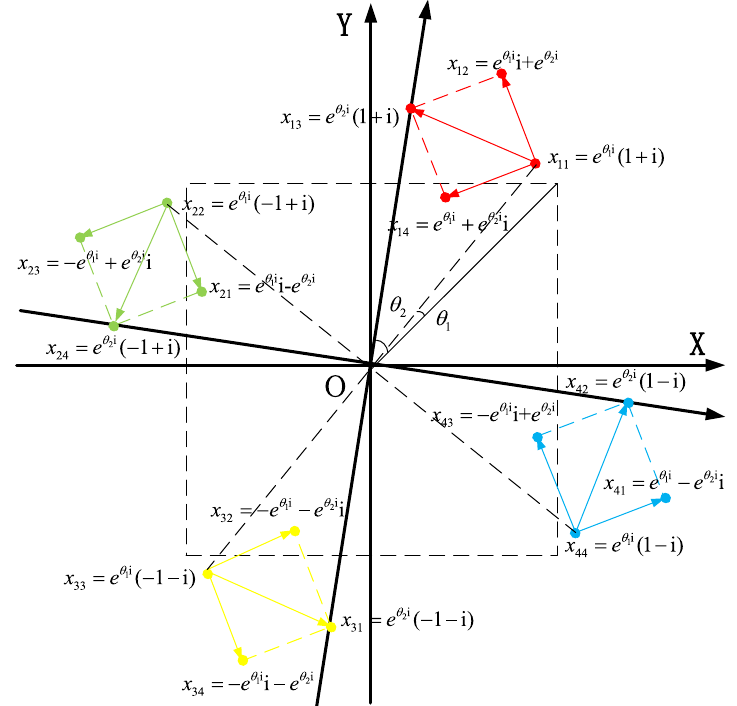
Fig. 4 Constellation pattern of